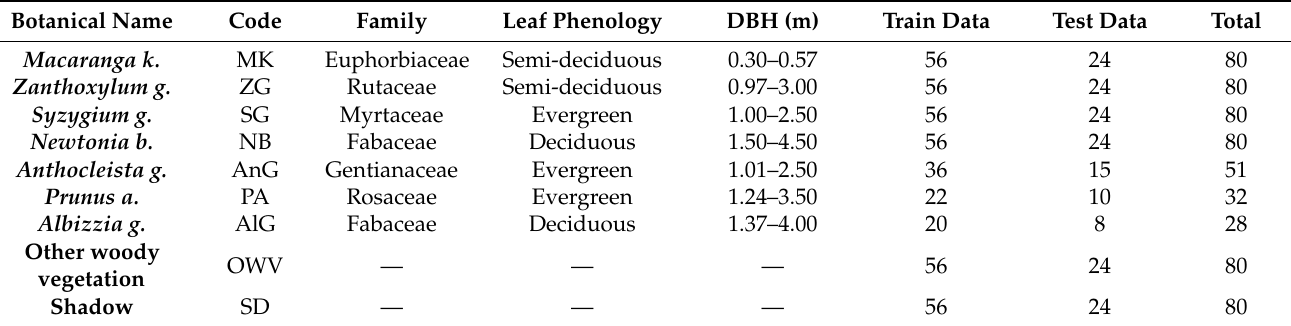
Table 1. List of tree species, codes, family, leafy phenology, diameter at breast height (DBH), number of individual tree crowns, and composition of training and test data for each species used to map trees in Mt. Kenya Forest Reserve. Botanical